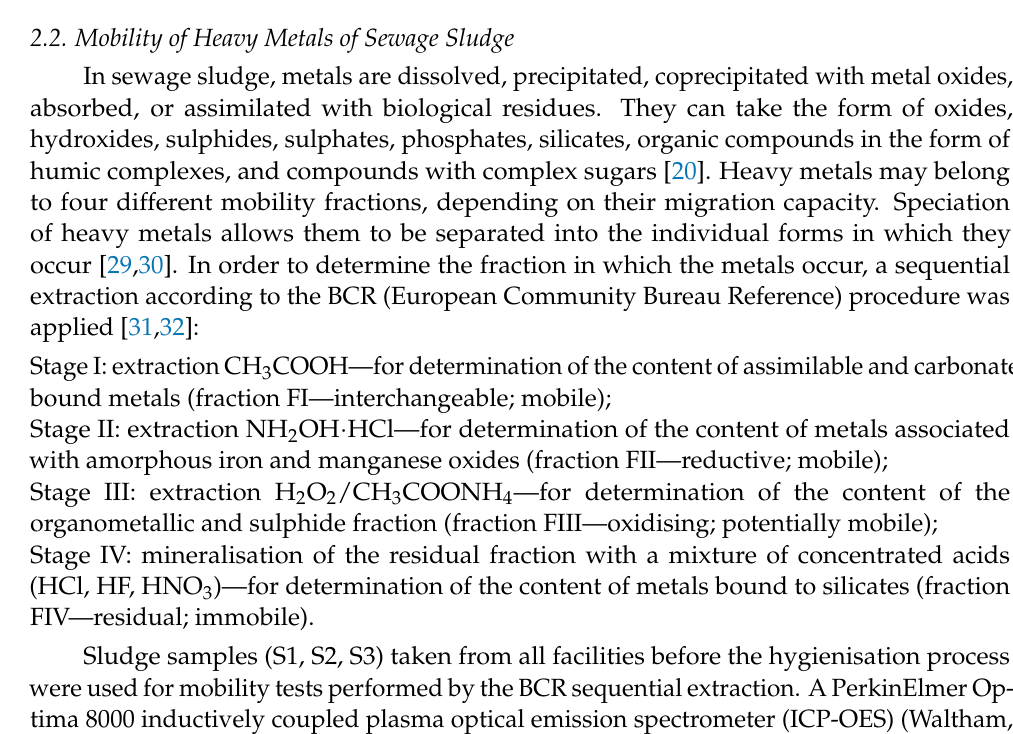
Table 4. Content of the element from the heavy metal group in agricultural soils of Ś wi ę tokrzyskie Voivodeship, mg ∙ kg − 1 d.m. [28].